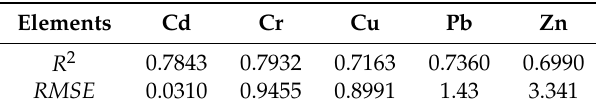
Table 4. The estimation results of the GRNN model.